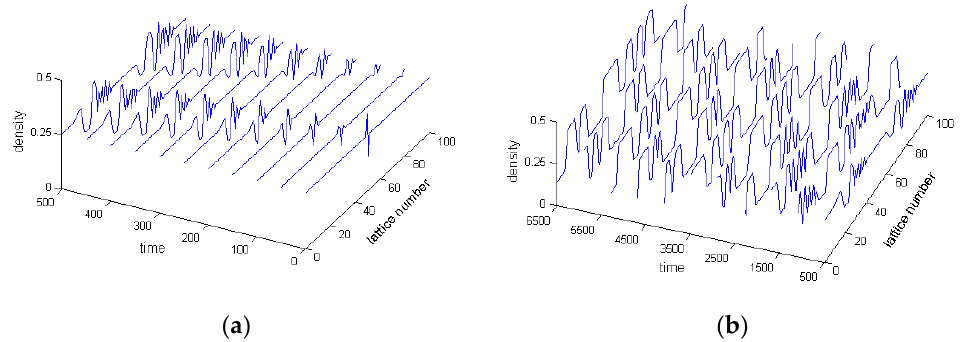
( a ) ( b ) ( a ) ( b ) ( a ) ( b ) Figure 3. Traffic wave-developing process of the new model when =0  and Figure 3. Traffic wave-developing process of the new model when =0  and Figure 3. Traffic wave-developing process of the new model when β = 0 and d ( k ) = round ( 3 + ( )=round(3+2sin( )) d k k , in which ( a ) in the first =500 t time step, ( b ) after =500 t time step. Figure 3. Traffic wave-developing process of the new model when =0  and ( )=round(3+2sin( )) d k k , in which ( a ) in the first =500 t time step, ( b ) after =500 t time step. 2sin ( k )) , in which ( a ) in the first t = 500 time step, ( b ) after t = 500 time step. ( )=round(3+2sin( )) d k k , in which ( a ) in the first =500 t time step, ( b ) after =500 t time step.